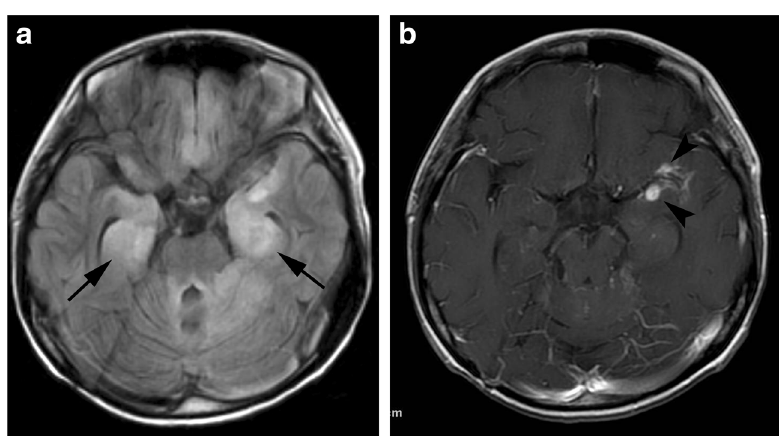
Fig. 1 Paraneoplastic limbic encephalitis. A 17-year-old boy with recurrent medulloblastoma presented with seizure and altered mental status. a FLAIR image shows hyperintensities in the mesial temporal regions ( arrows ). b Contrast enhanced fat- suppressed T1-weighted image shows nodular meningeal enhancements in the left Sylvian fissure ( arrowheads ), suggestive of